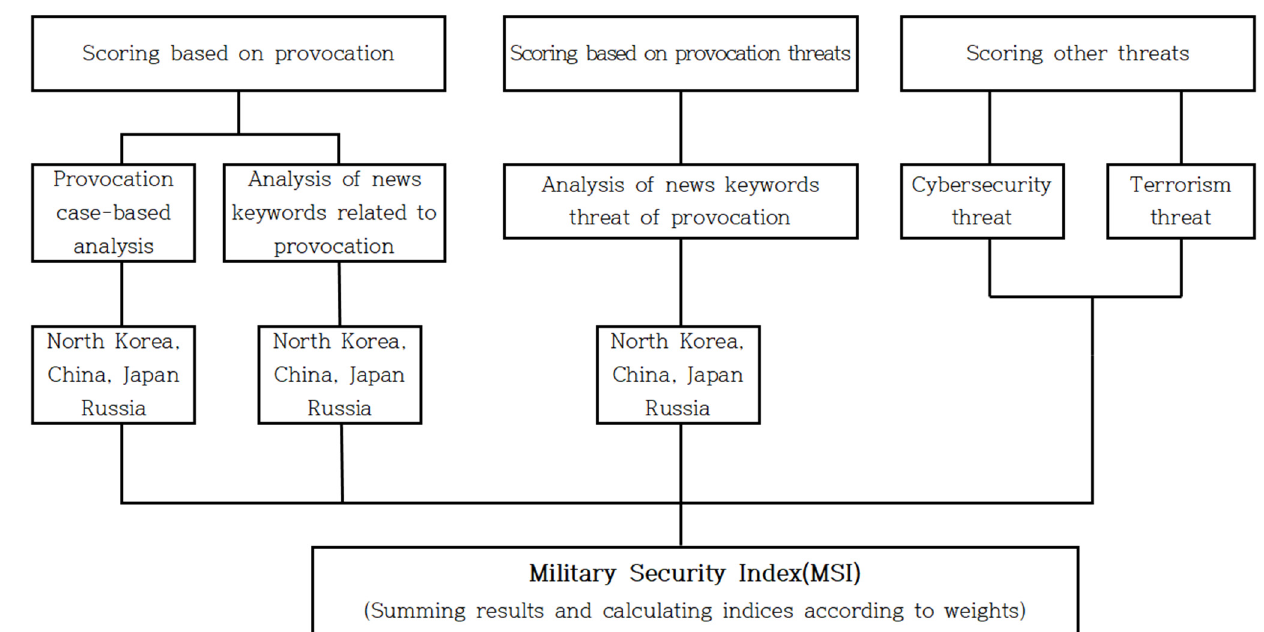
Figure 1. Military Security Index research model.